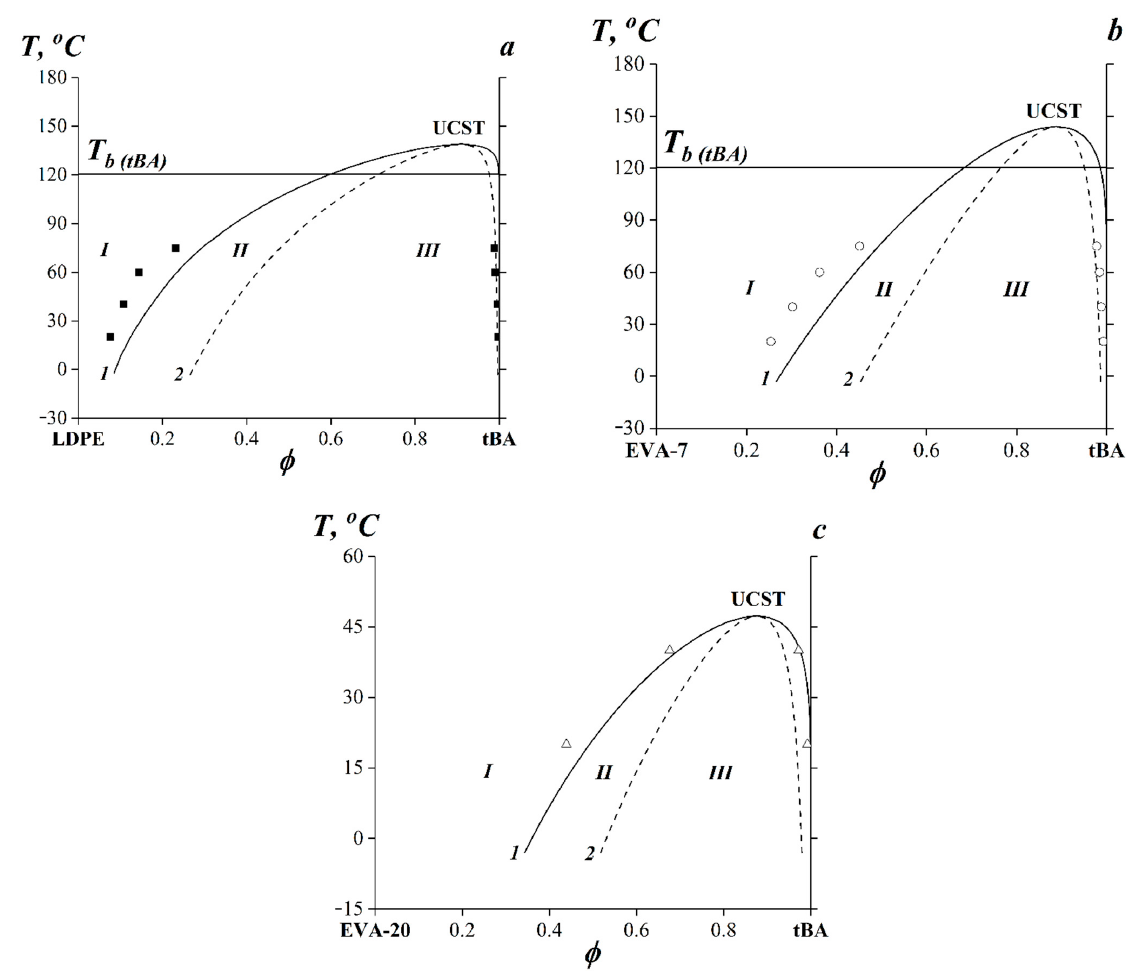
Figure 7. Phase-state diagrams for LDPE–tBA ( a ), EVA-7–tBA ( b ), EVA-20–tBA ( c ) systems. The markers indicate the experimental data. Curve 1 (black solid line)—calculated binodal curves. Curve 2 (black dashed line)—calculated spinodal curves. I —the region of true solutions, II —the region of metastable states, III —the region of labile structures.